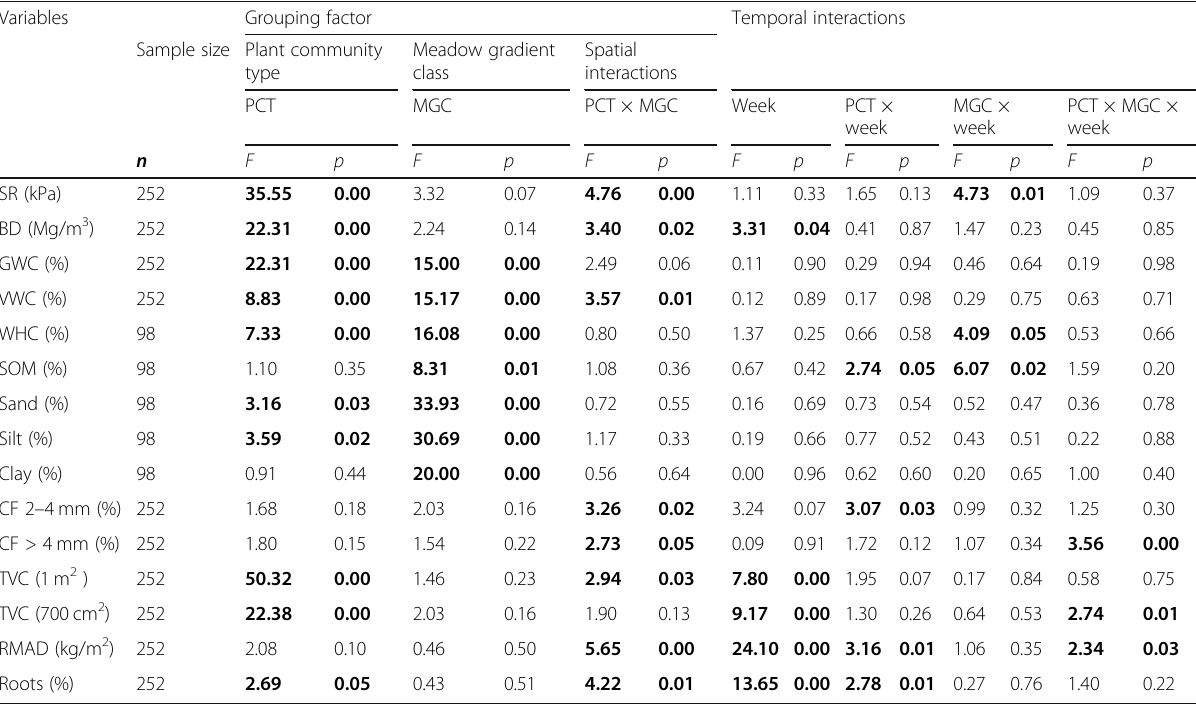
Table 3 Results of three-factor ANOVAs for soil resistance (SR) and various explanatory variables. Two grouping factors represent different spatial scales: plant community type (local scale) and meadow gradient class (meadow scale). The other grouping factor (week) denotes the sampling week that the variable was measured over a 3-week study period (temporal effect). Note: different plots were sampled each week across all five meadows. Bolded F and p values ( F ) indicate variables with significant differences ( p < 0.05) for that factor or interaction. Acronyms and abbreviations: BD bulk density, GWC gravimetric water content, VWC volumetric water content, WHC water holding capacity, SOM soil organic matter content, Sand % sand content, Silt % silt content, Clay % clay content, CF coarse fragment content in two size classes (2 – 4 mm and > 4 mm), TVC total vegetation cover in two